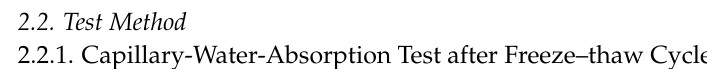
Table 6. Mix ratio of nano-TiO 2 recycle aggregate concrete (kg/m 3 ).